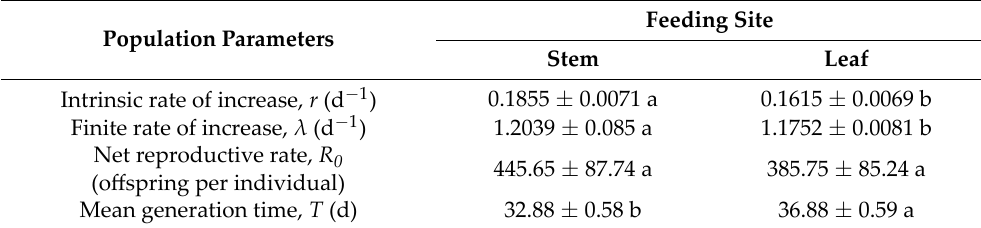
Table 3. Population parameters of S. litura fed on different tissues of asparagus. Population Parameters